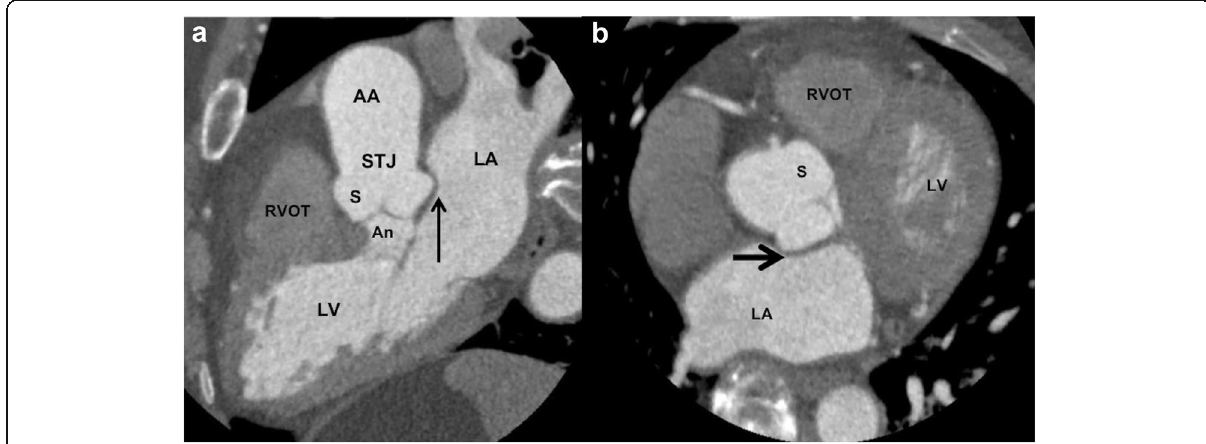
Fig. 3 Reformatted 3-chamber view ( a ) and axial ( b ) CTA of the heart and proximal aorta showing the normal relation of the aortic root to the left atrium. No soft tissue should be present between the wall of the left coronary sinus and the left atrium (black arrow). In patients with aortic root infection, this space (black arrow) is increased with soft tissue. Abbreviations: AA, ascending aorta; LA, left atrium; LV, left ventricle; PA, pulmonary artery; An, annulus; S, sinus of Valsalva; STJ, sinotubular